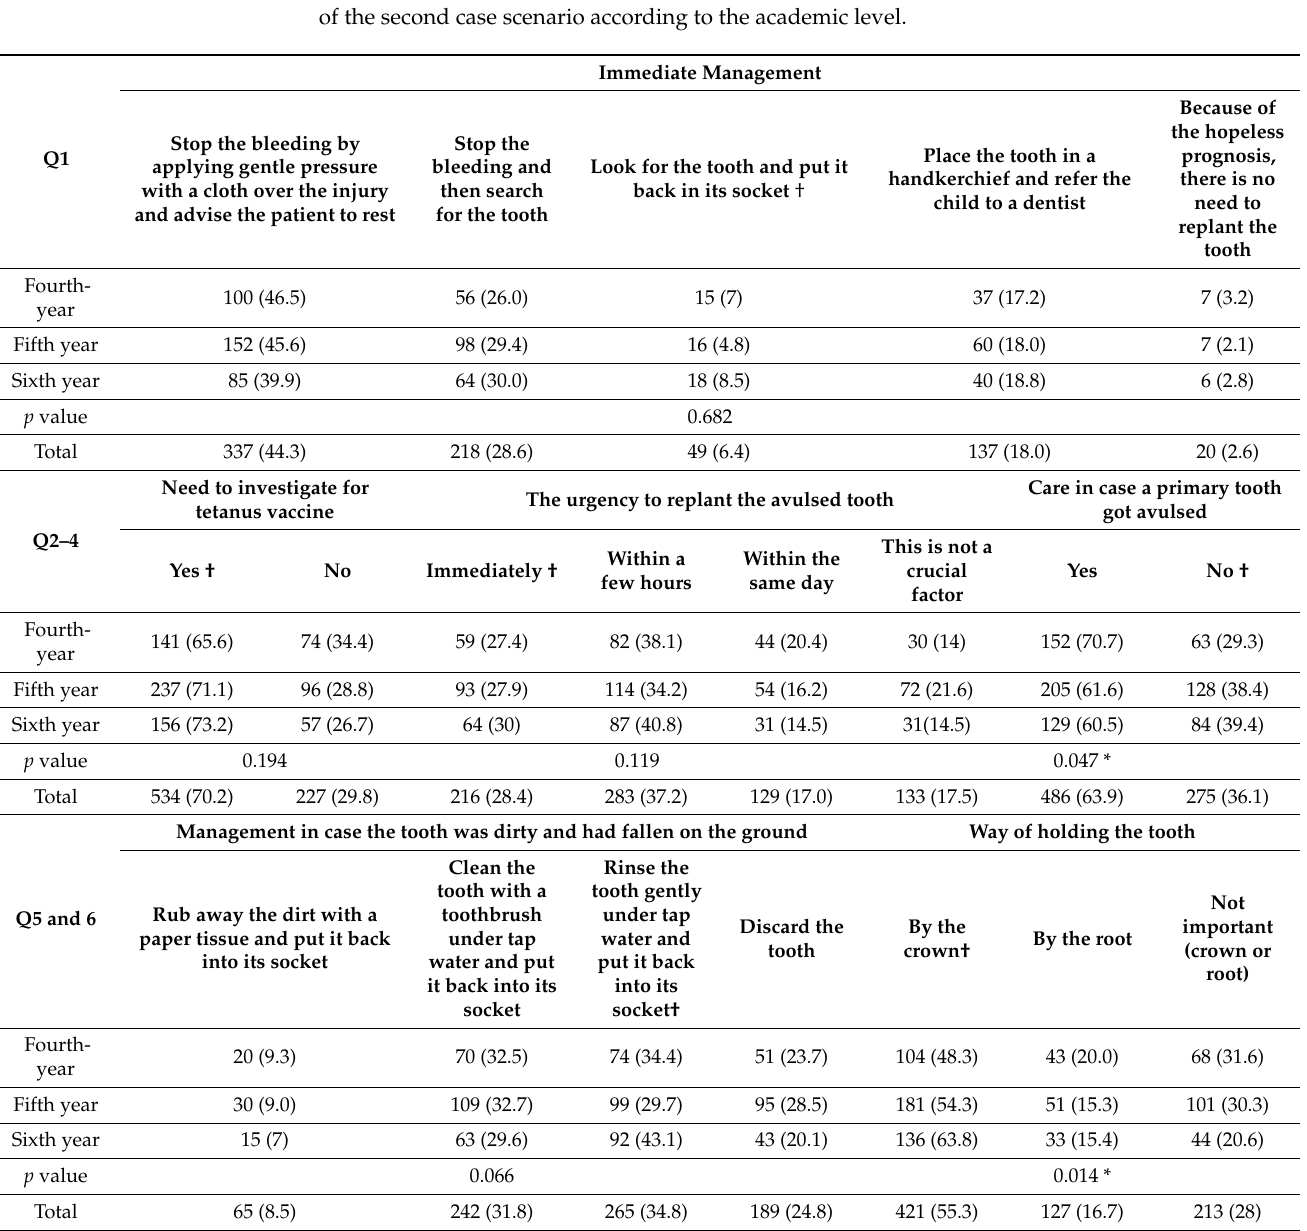
Table 2. The frequency and percentage, N(%), of medical students’ responses to the first six questions of the second case scenario according to the academic